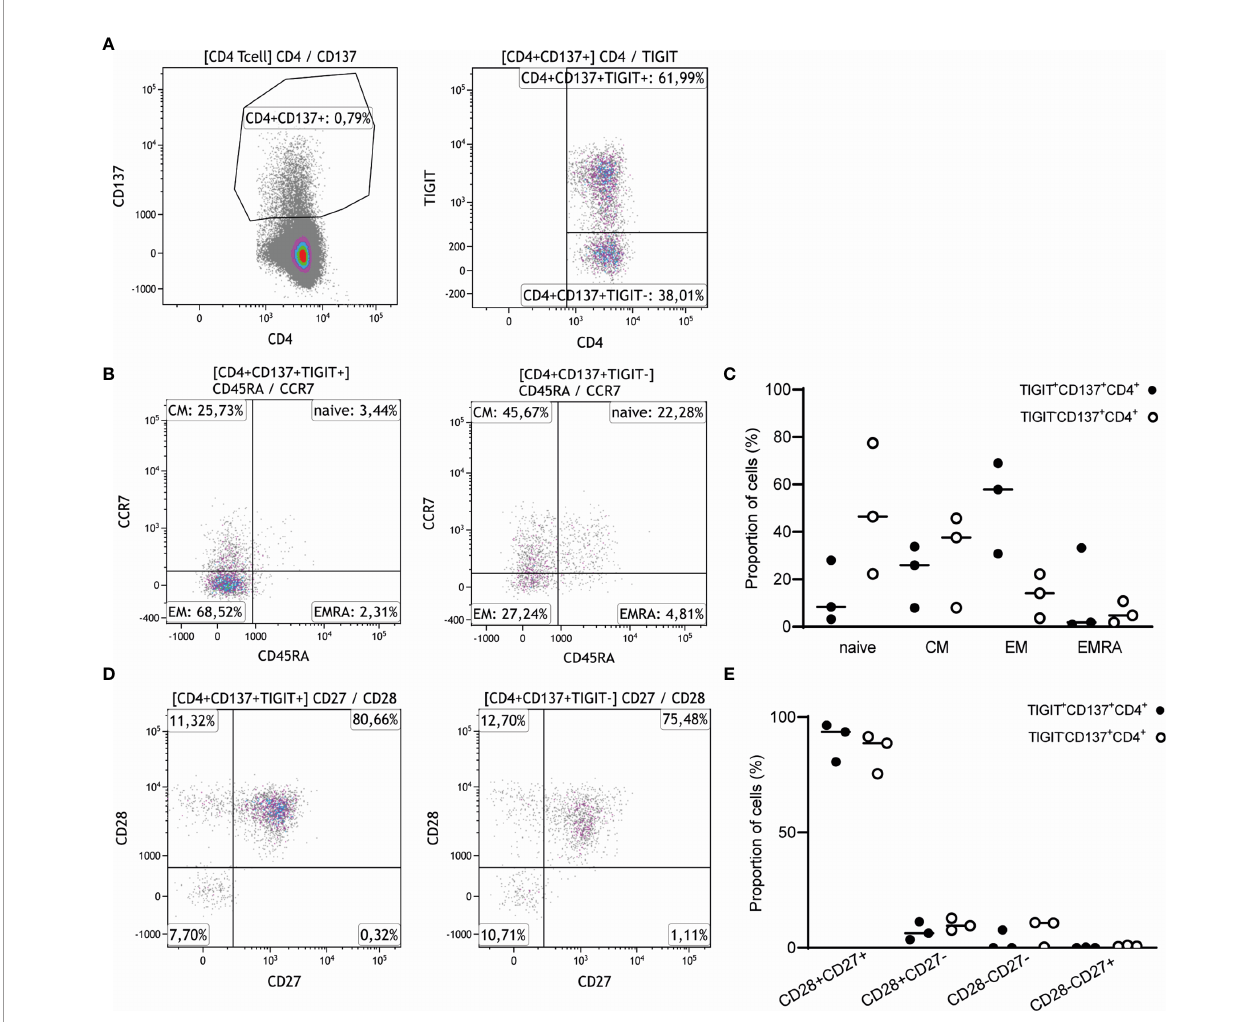
FIGURE 4 | CD4+CD137+TIGIT+ T cells have a predominantly central and effector memory T cell phenotype and express both CD27 and CD28. (A) A representative sample of the 3 healthy individuals stimulated with alloantigen illustrates how CD4+CD137+ T cells were gated and split into a TIGIT positive and TIGIT negative fraction. (B) Expression of CD45RA and CCR7 was compared for both CD4+CD137+ T cells expressing TIGIT (left) and negative for TIGIT (right) of 3 healthy individuals. The percentage of gated CD4+CD137+TIGIT+ and gated CD4+CD137+TIGIT- cells are indicated within each quadrant. (C) Naïve, central memory (CM), effector memory (EM) or terminally differentiated effector memory (EMRA) cells are depicted as proportion of CD4+CD137+ T cells either positive (closed symbols) or negative (open symbols) for TIGIT of 3 healthy individuals. (D) Expression of CD27 and CD28 was illustrated for both CD4+CD137+ T cells expressing TIGIT (left) and negative for TIGIT (right). The percentage of gated CD4+CD137+TIGIT+ and gated CD4+CD137+TIGIT- cells are indicated within each quadrant. (E) The proportion of CD4+CD137+ T cells either positive (closed symbols) or negative (open symbols) for TIGIT and expressing CD28 and CD27 are